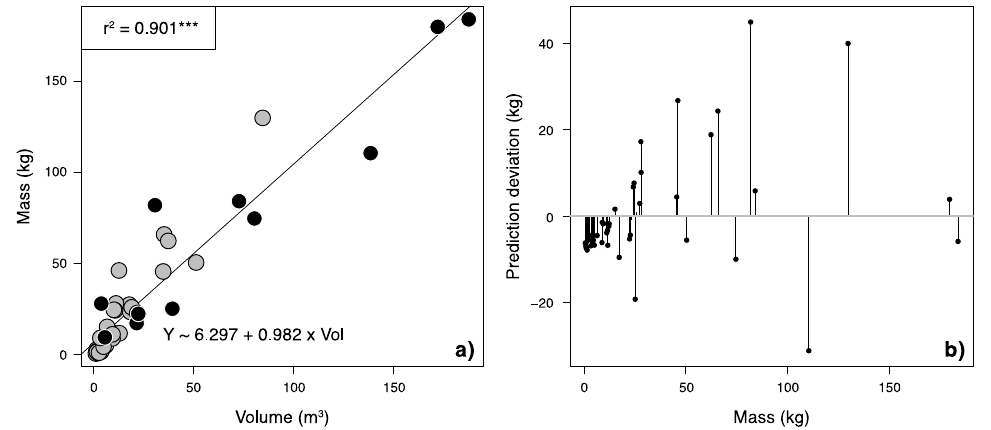
Figure 2. ( a ) The linear volumetric allometric model combining singular trees (grey dots) and stands (black dots). ( b ) Original masses plotted by the deviation of predicted values to original values. *** = p < 0.001.